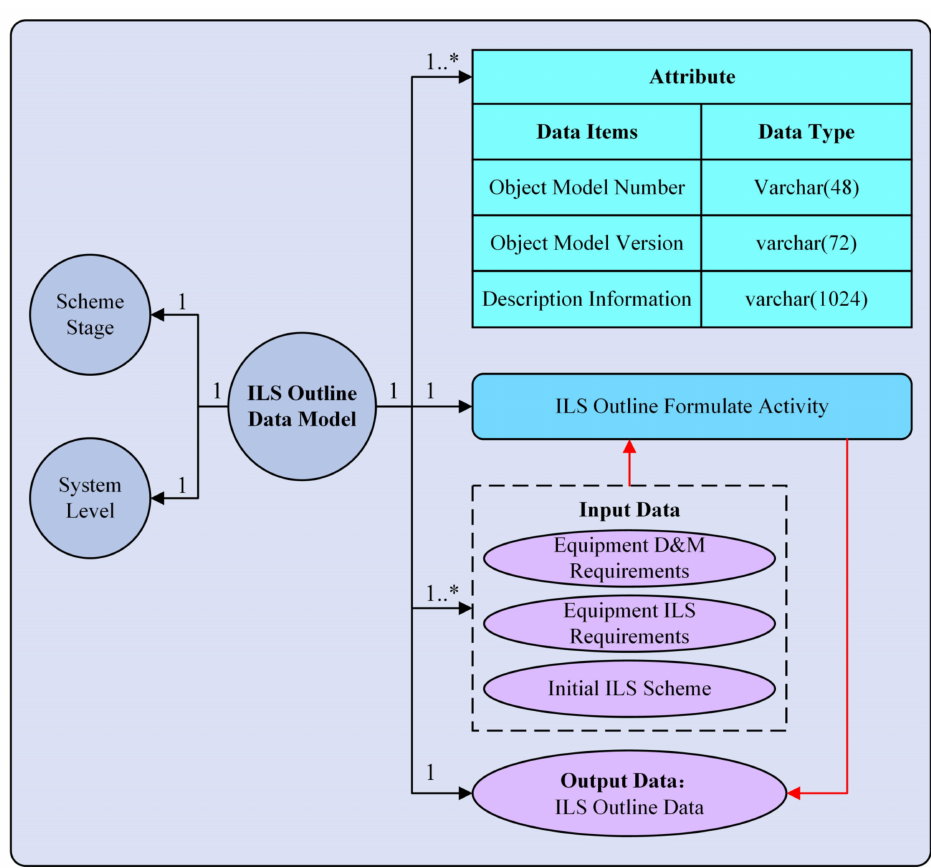
Figure 8. ILS Instantiated unified data model